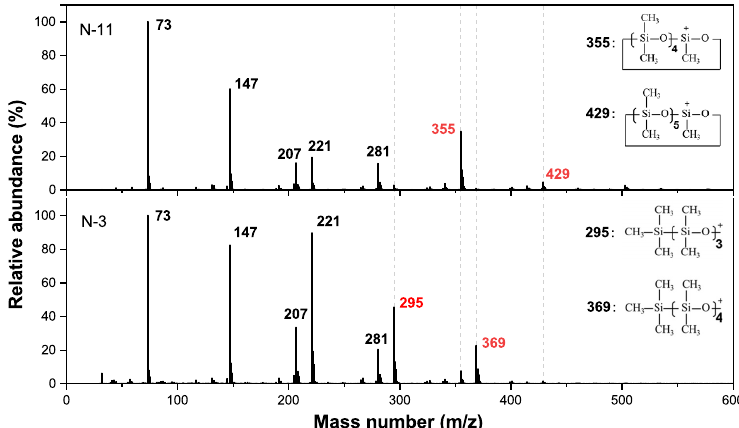
Figure 2. Mass spectra of N-3 and N-11 in GC–MS of the silicone rubber extracts. As shown in Figure 2, structures for m/z of 295, 355, 369, and 429 are plotted. It can be seen that the m/z of 355 and 429 are fragments of cyclic siloxanes, while the m/z of 29 and 369 are fragments of linear siloxanes. The differences between the mass spectra of N-3 and N-11 are that N-3 has more m/z of 295, 369 than N-11, and N-11 has more m/z of 355, 429 than N-3. The result indicates that N-3 has many more methyl end-groups. Referring to the data on soft ionization published in the literature [20], we propose that peak N-3 is a linear LMW siloxane, and peak N-11 is a cyclic LMW siloxane. Thus, the peak N-11 represents the substance of D 11 , while N-3 represents the substance of L 10 (L n =CH 3 [(CH 3 ) 2 SiO] n Si(CH 3 ) 3 ). Based on the above discussion, peaks from N-11 to N-19 are cyclic siloxanes from D 11 to D 19 , and peaks from N-1 to N-10 are linear siloxanes from L 8 to L 17